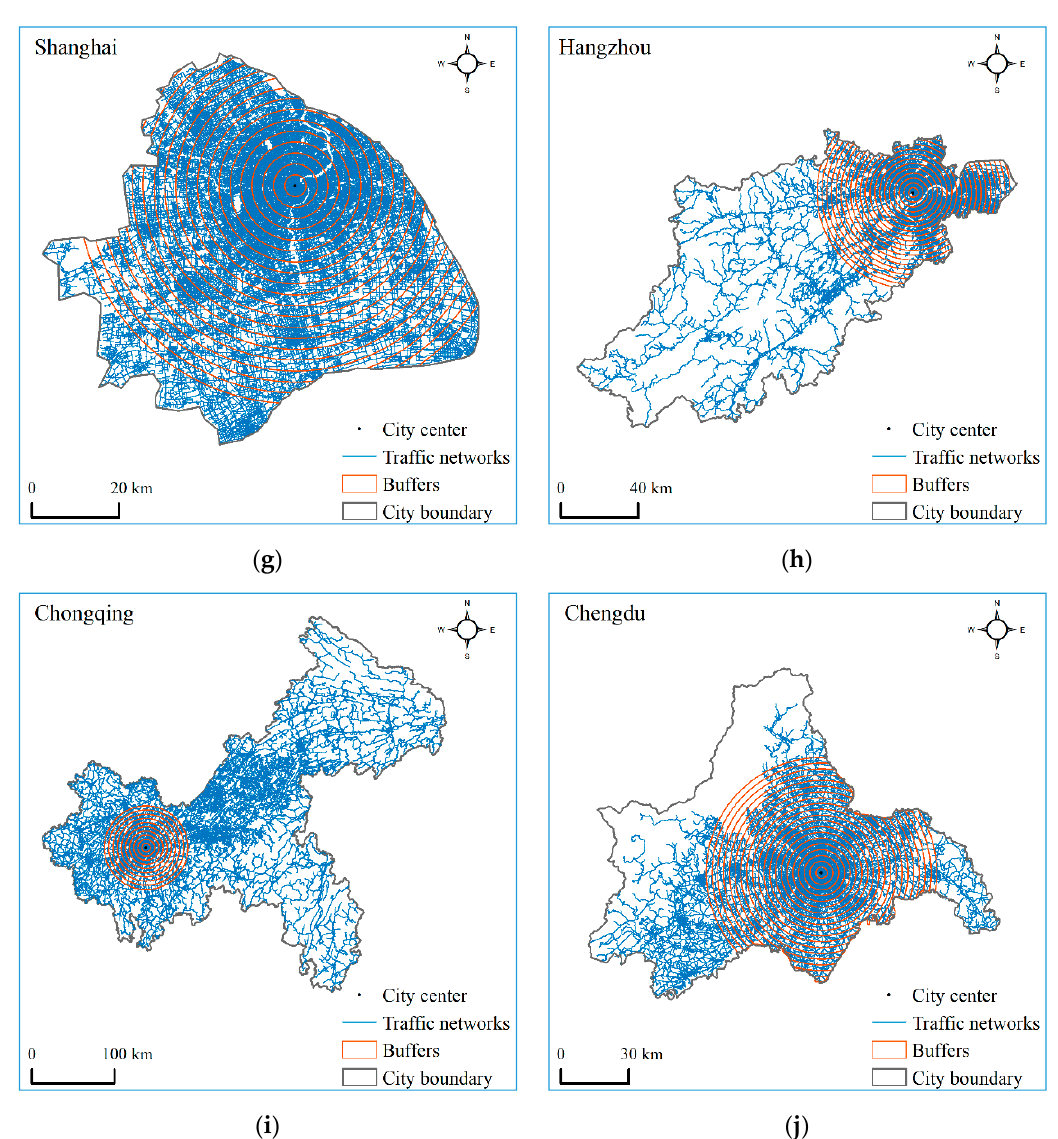
Figure 1. Traffic networks in 10 Chinese cities based on administrative boundaries in 2016. ( a ) Beijing; ( b ) Tianjin; ( c ) Guangzhou; ( d ) Shenzhen; ( e ) Wuhan; ( f ) Nanjing; ( g ) Shanghai; ( h ) Hangzhou; ( i ) Chongqing; ( j ) Chengdu. Note: The data extraction for spatial signals is confined by each municipal boundary, so that the spatial information is not complete. In this case, it is improper to estimate the fractal parameter using simple fractal model. It is advisable to apply wave-spectrum scaling analysis to these spatial patterns.